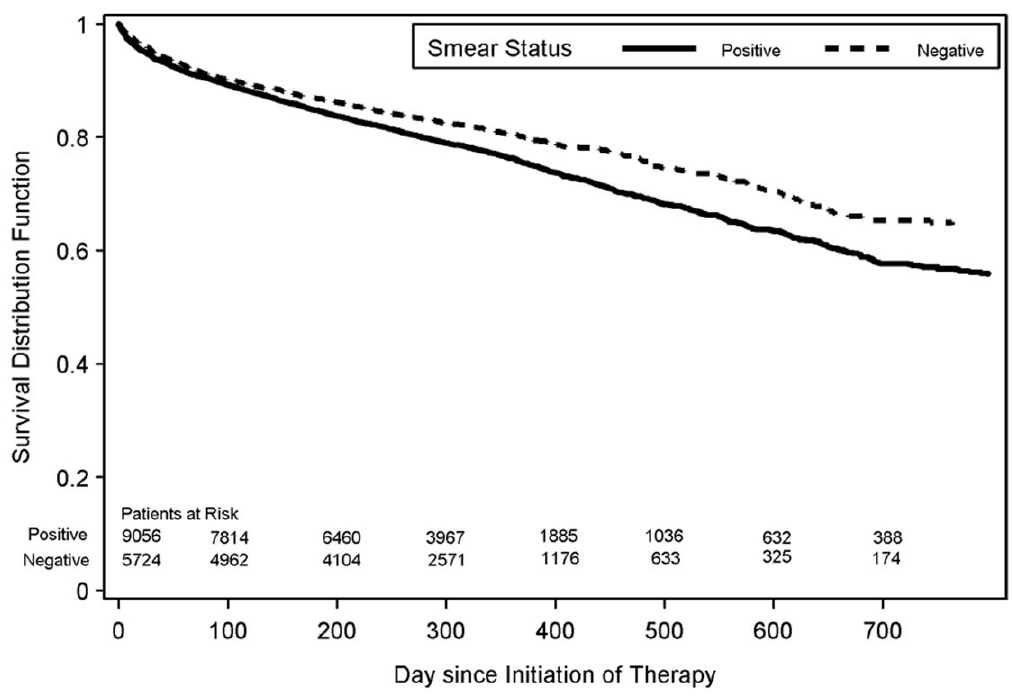
Figure 2. Survival Curves for patients with HIV-infection and culture-confirmed pulmonary TB, by sputum smear result, United States, 1993–2006. Solid line indicates the Kaplan-Meier survival curve for smear-positive patients. Dotted line indicates the Kaplan-Meier survival curve for smear-negative patients.